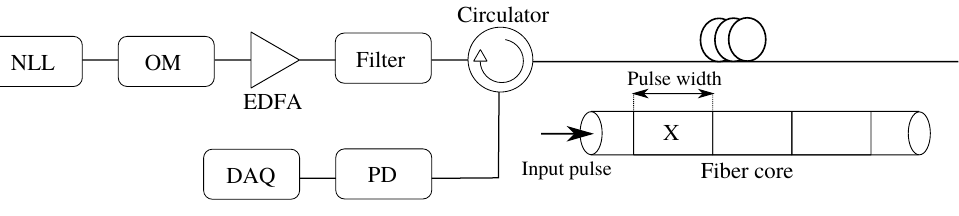
Figure 3. Basic scheme of Φ